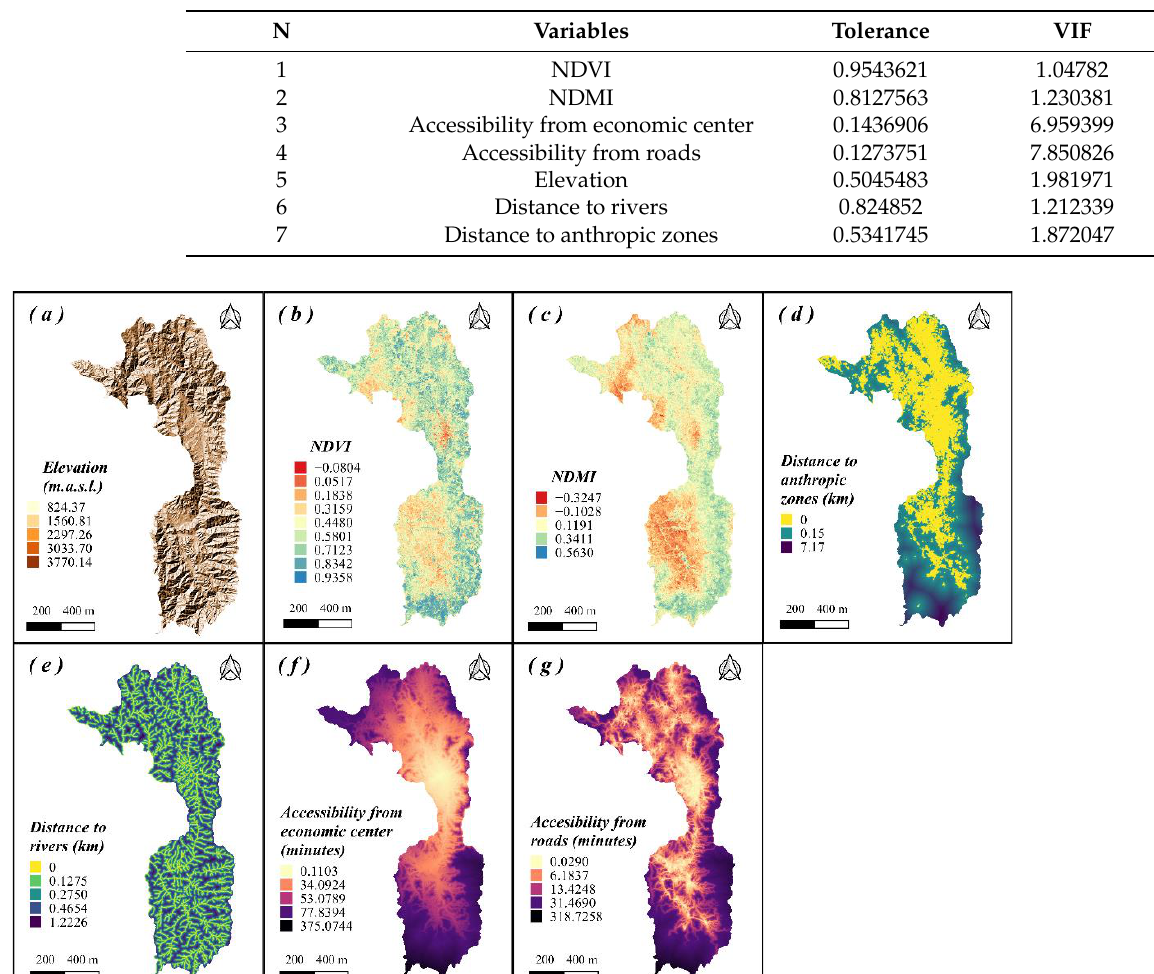
Table 1. Multicollinearity analysis in the current study.